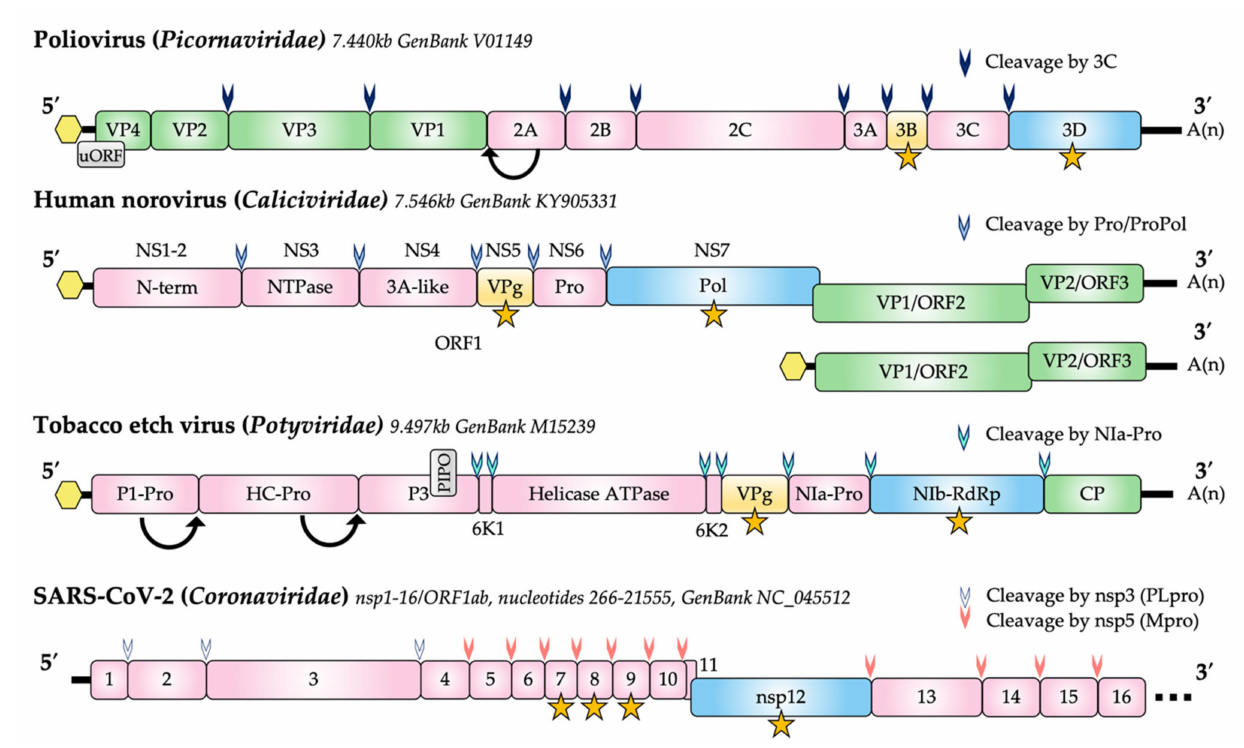
Figure 1. Genome structure of representative members of the Caliciviridae, Potyviridae, Picornaviridae and Coronaviridae . The presence of a covalently attached (nucleotidylylated) 5 (cid:48) VPg is shown as a yellow hexagon. The coding region for VPg proteins is shown in yellow and proteins known to be nucleotidylylated are indicated by a yellow star. Proteolytic processing of viral polyproteins are indicated by arrowheads. Potyvirus P1-Pro and HC-Pro self-cleave from the polyprotein (arrows). Viral capsid proteins are shown in green and the RNA-dependent RNA polymerases (RdRp) are shown in blue. Non-structural proteins (nsp) other than RdRp and VPg are shown in pink with the common name and/or nsp designation indicated. A second reading frame (uORF) produced by poliovirus is shown in grey. The PIPO coding region expressed as a fusion to P3 via a polymerase slippage mechanism is shown in grey for tobacco etch virus. In caliciviruses, the protease (pro) and polymerase (RdRp) are found as unprocessed precursors, analogous to 3CD in picornaviruses. The NS and VP1 genes of some calicivirus genera (e.g., lagoviruses) are a single ORF. Nucleotide lengths for the genomes depicted are indicated and genomes are not to